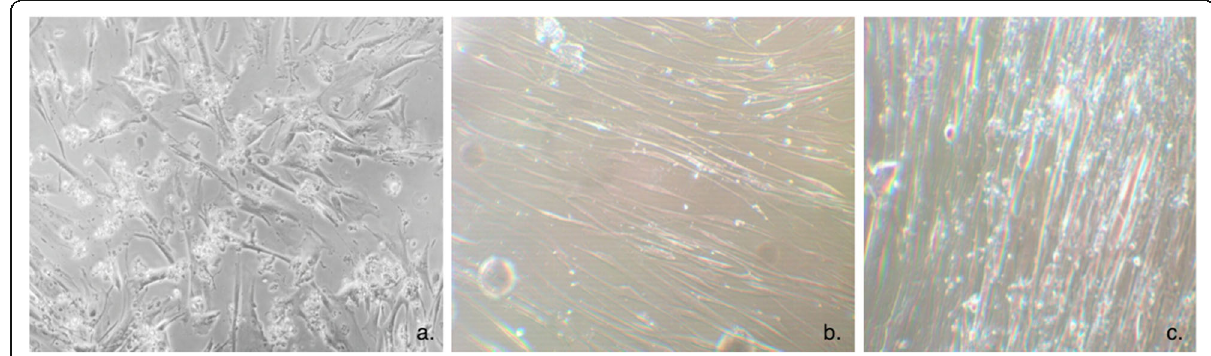
Fig. 6 Human fibroblasts forming a dense monolayer on tantalum-coated glass, with cellular adhesion ( a ). A direct comparison of the density of the Human Fibroblast monolayer after 28 days on uncoated glass ( b ) and tantalum-coated glass ( c